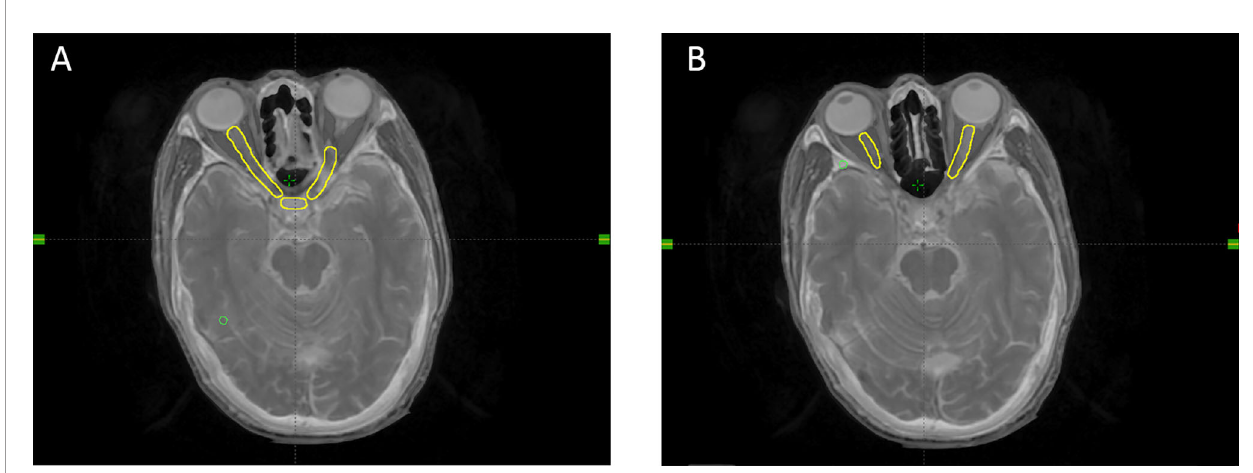
FIGURE 1 | An example of neuro-optic structures (A, B)